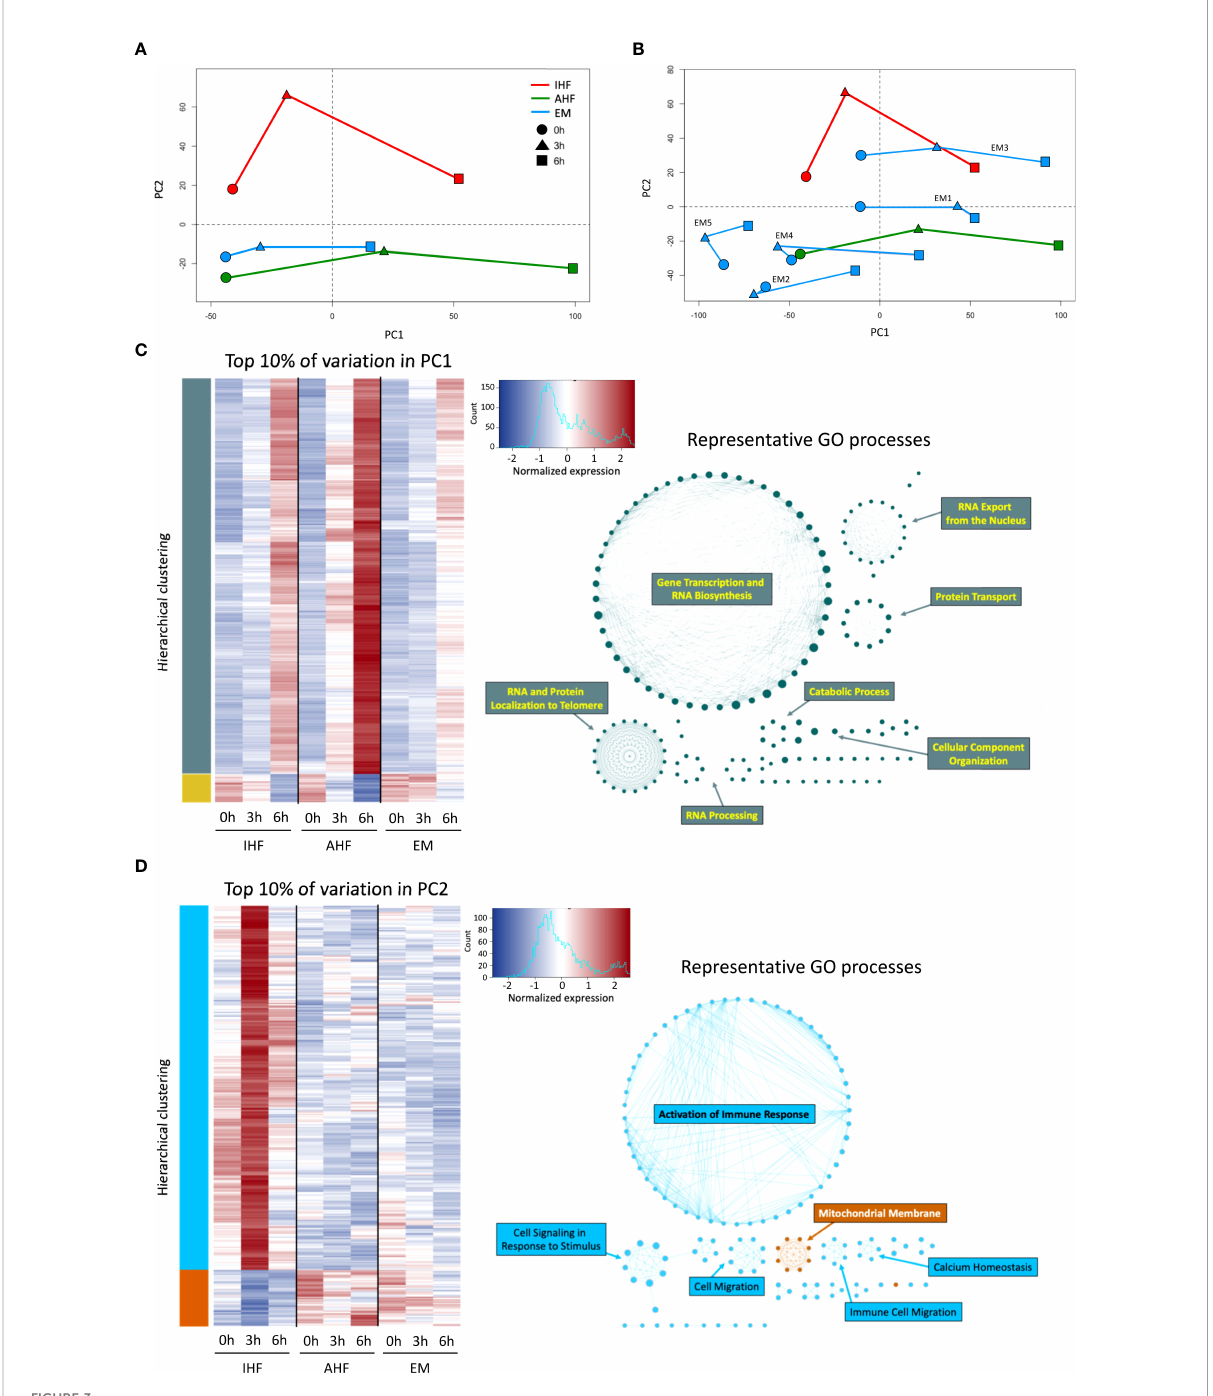
FIGURE 3 Principalcomponentandgeneontology analysisof transcriptionalchangesduringNMP. PCAof EM, AHF,and IHFgroups forPC1and PC2at0(pre- perfusion),3, 6hoursof NMP shown in (A) composite formand (B) withindividualEMlivers. PC2clearly distinguishes AHFfromIHFlivers,whereasPC1 capturestime-dependenttranscriptionalchanges. Theworstfunctioningliver(EM5)demonstratesthe least transcriptional changeduringNMP. (C) Hierarchical clusteringheatmapof the top10%of genes accountingforthevariationinPC1. GOnetworkanalysis indicatesPC1isenriched forgene expression accountingforDNAtranscriptionandRNAtranslation(teal networks), whichisupregulatedinall three groups duringNMP. D)Thetop10%of genes accountingforthevariationinPC2showremarkabledifferences betweenthethree groups. GOnetworkanalysisindicatessigni fi cantupregulation ofgenes involvedinimmuneresponseactivation andcellmigration(lightblue networks)intheIHFgroupcomparedtoAHF andEMgroups. AHFandEM groupsdemonstratedcomparatively increasedexpressionofgenesrelatedtomitochondrial membraneintegrity(orangenetwork)comparedtoIHFlivers. AHF, adequatehepatocellularfunction;IHF, inadequatehepatocellularfunction;EM,emricasan;PC,principal